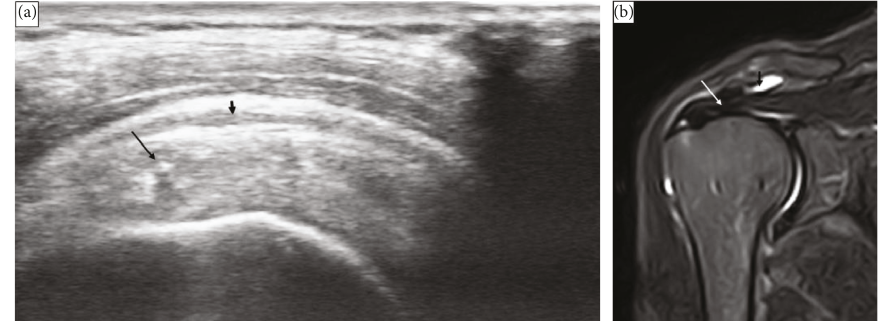
Figure 2: Ultrasound and MRI findings in a 46-year-old male patient with a 5-year history of hemodialysis with unilateral shoulder pain for 6 month. (a) US scan of supraspinatus tendon on its long axis shows thickness of the tendon with loss of its normal fibrillar pattern (long arrow) with minimal fluid collection at the subacromion subdeltoid bursa (short arrow) denoting supraspinatus tendinosis and sub- acromion subdeltoid bursitis. (b) MRI shoulder coronal STIR images revealed subacromion subdeltoid bursitis (short arrow) and supraspinatus tendinosis (long arrow).